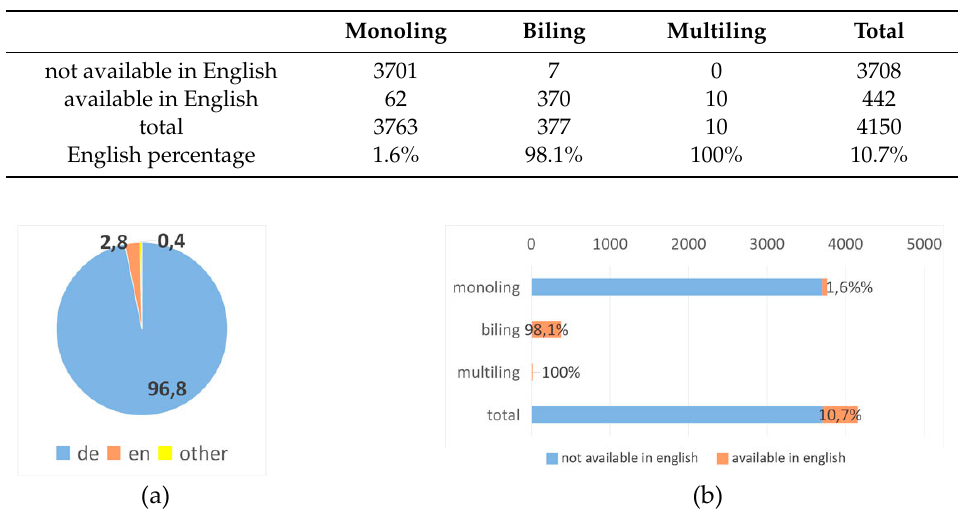
(b) Figure A10. Visualization of the results for domain fr. a) Primary languages pie chart and b) English